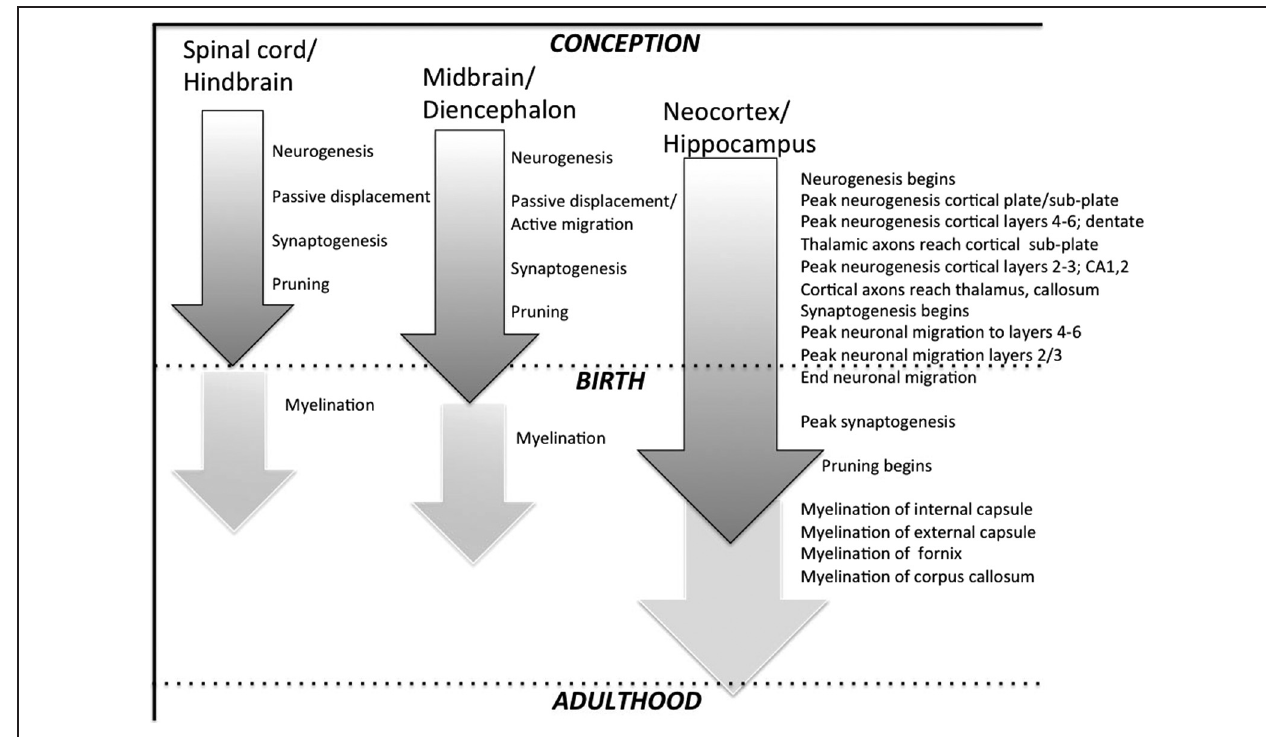
but actively in cerebral cortex), synaptogenesis, and pruning. Off-white arrows depict myelination, which largely begins postnatally, and continues into adulthood in many higher-order